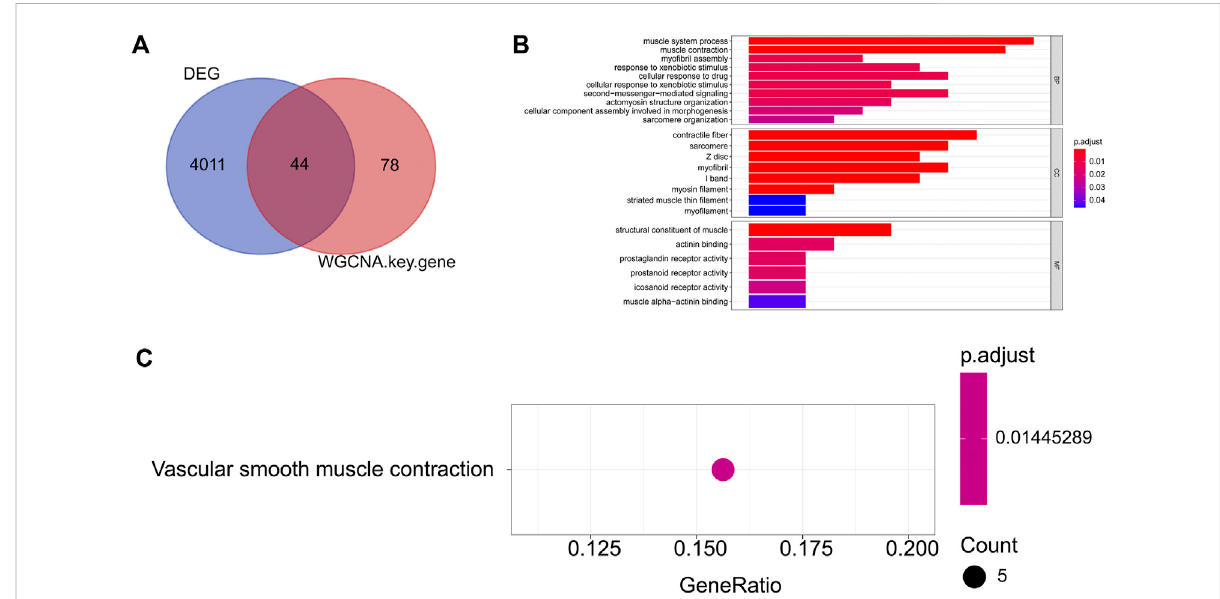
FIGURE 3 GOandKEGGenrichmentofendometriosis-relatedDEGs (A) TheVenndiagramoftheDEGsandkeymodulegeneswereidenti fi edbyWGCNA;